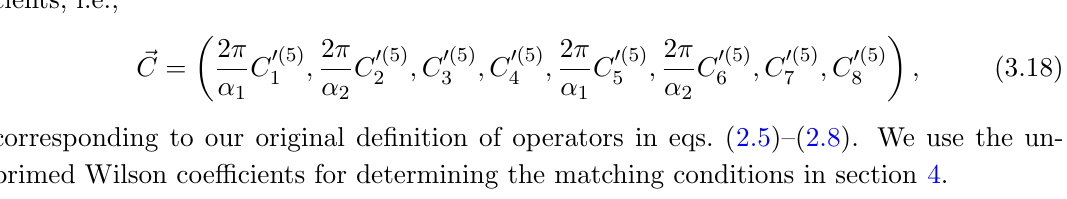
Figure 6 . Sample diagrams for mixing of the dipole operators Q 0 (5) operators Q 0 (5) and Q 0 (5) 3 4